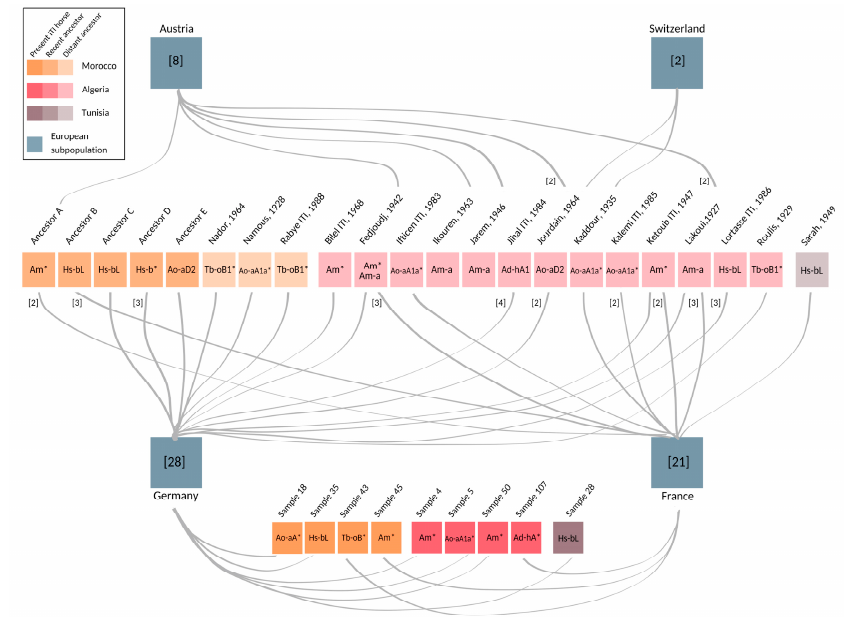
Figure 3. Maghrebian roots of European stallions. Fifty-nine European individuals, who were imported or their patrilines trace back to North Africa, are grouped based on their current registry (blue boxes). Number of horses included from Austria (n = 8), Switzerland (n = 2), Germany (n = 28), and France (n = 21) are denoted in square brackets. The paternal ancestors of the sampled individuals several generations back in time, as well as present individuals imported to France and Germany, are shown as colored boxes. The opacity of boxes indicates temporal layers whereas the brightest boxes on the bottom are present ITI horses, followed by recent ancestors born after 1990 (Ancestor A, B, C, D, and E), and lightest colored distant ancestors, in the middle. Name and year of the birth of ancestors is given for distant ancestors. MSY HTs, revealed from the European progeny, are shown within each stallion’s box. HT identifiers attributed with asterisk (*) denote inner node clustering. The grey lines connect the stallions with their descendants sampled in the respective European countries. Numbers in the brackets and adjacent to the left side of connection lines represent the number of descendants from each stallion found in European samples, if different from one. Pedigree details and full list of samples are given in Supplementary Table S1.